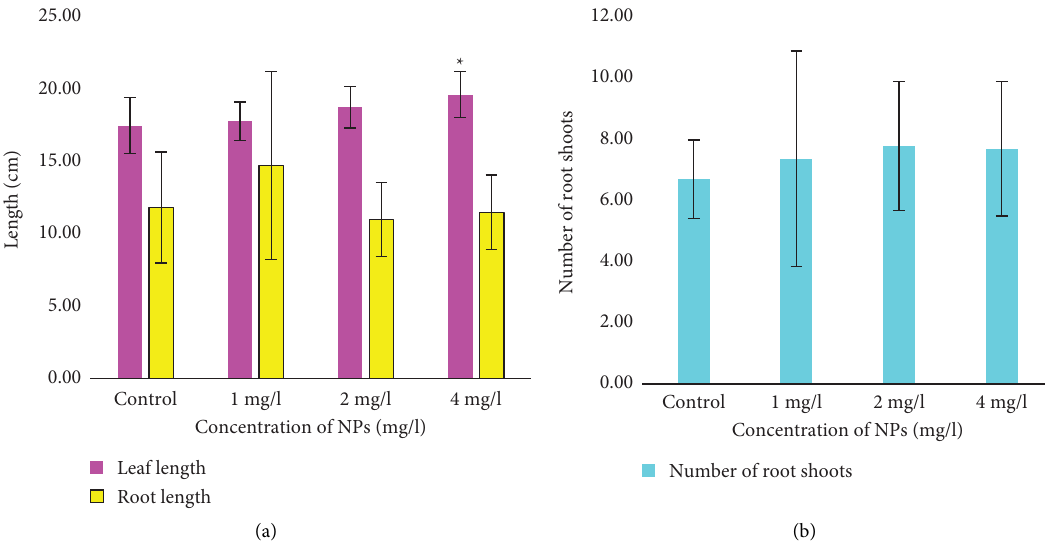
Figure 3: Leaf and root lengths (a) and a number of roots (b) of common wheat ( Triticum aestivum L.) after 15 days of treatment with ZnO NPs. Te values are the means of three replicates with a standard deviation. ∗ indicates a statistically signifcant diference compared to the control ( P <